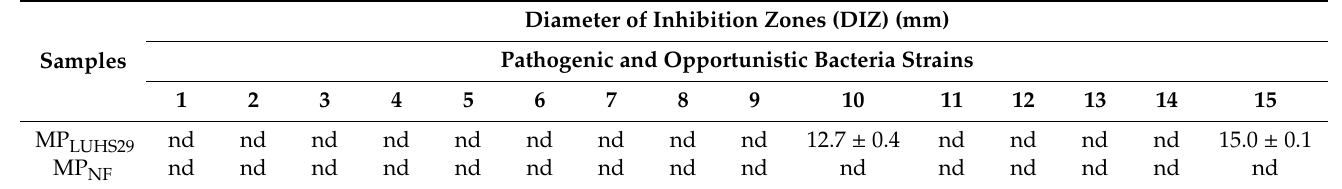
Table 2. The diameter of inhibition zones (mm) of the prepared beverages against pathogenic and opportunistic strains of milk permeate fermented with LUHS29